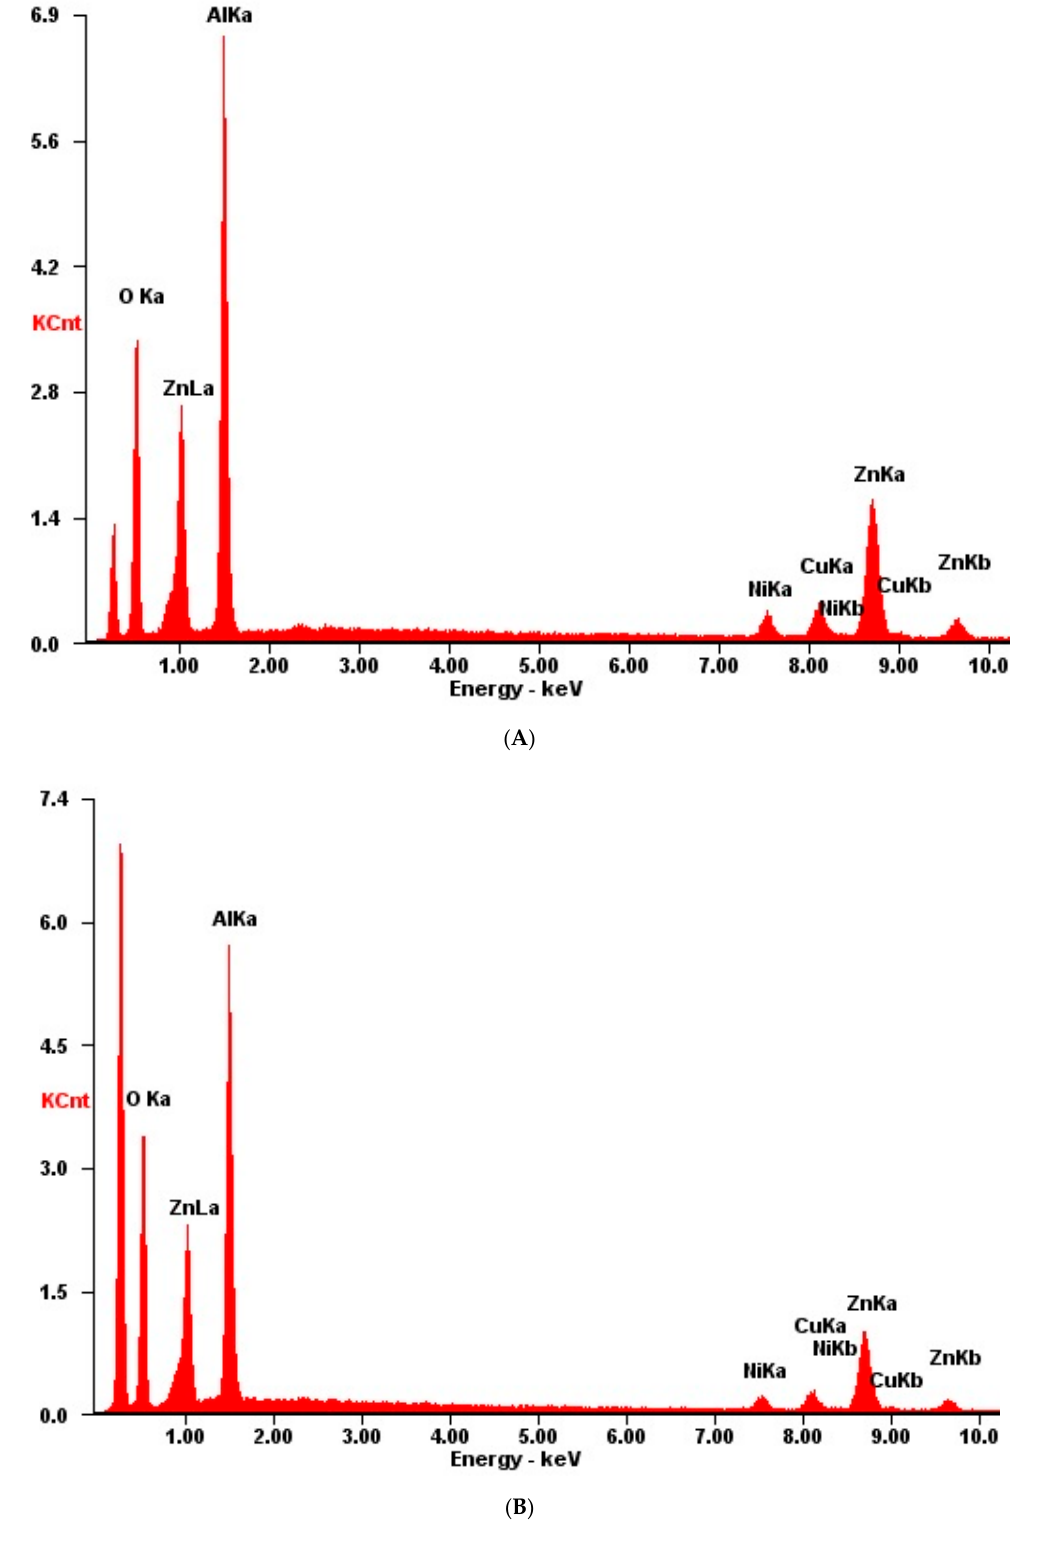
Figure 5. The EDS (energy dispersive spectroscopy)patterns of catalysts ( A ) the fresh catalyst and ( B ) the used catalyst.